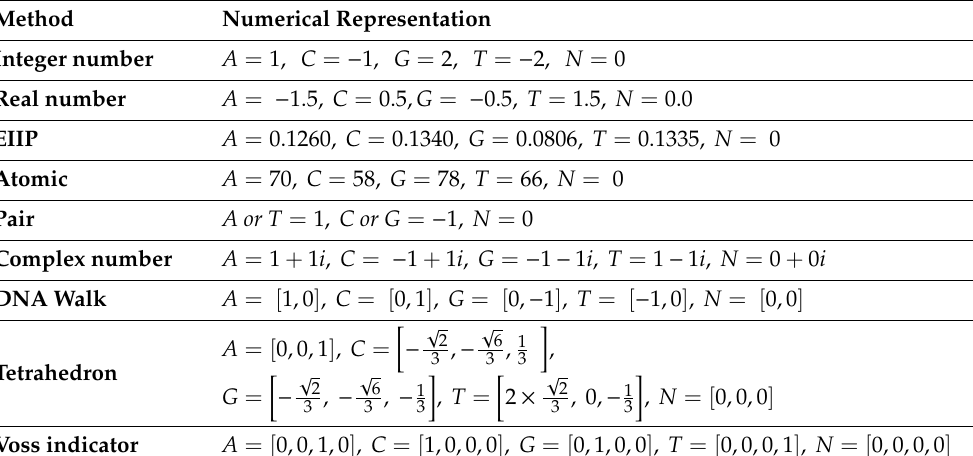
Table 1. Numerical nucleotide sequence representation